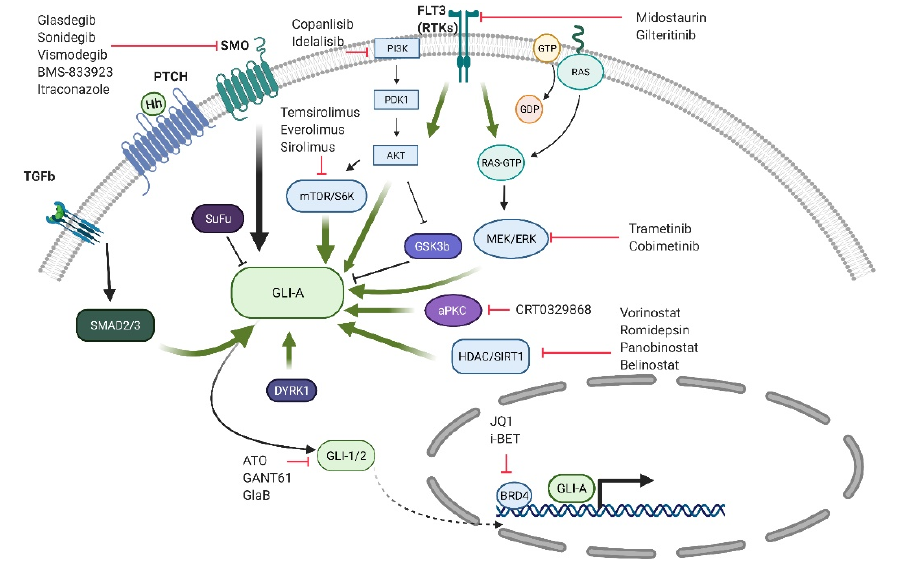
Figure 2. SMO-independent GLI activation. Several oncogenic pathways are capable of activating GLI downstream of SMO. Potential therapeutic strategies and their targets are listed (illustrated using BioRender.com, accessed on 14 June 2021).